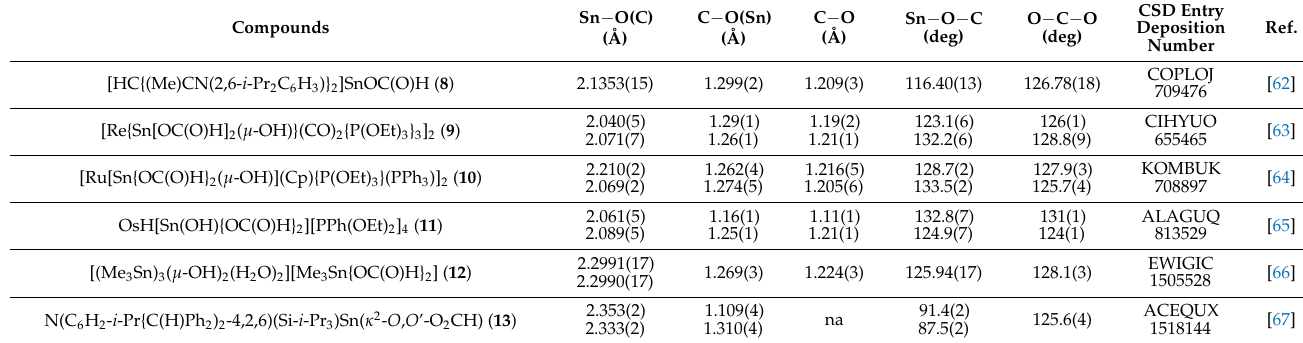
Figure 16. Molecular structure of 13 , adapted from [67] (MERCURY view). Hydrogen atoms are omitted for clarity except that of the formate group (Sn light blue, O red, N dark blue, Si orange, C grey, H white). Table 3. Comparison of selected structural parameters found in formates of organotin complexes. Compounds